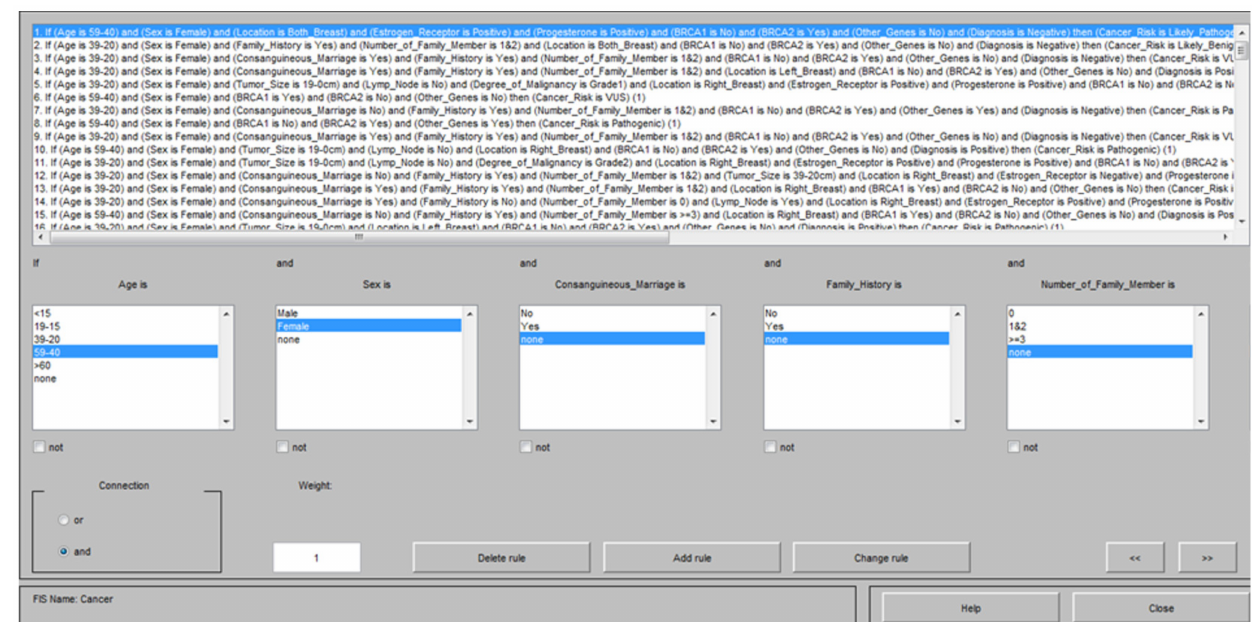
Figure 2. The figure illustrates generated rules section within the Fuzzy Logic system. The upper rectangle box presents an example of the data from 268 patients used that used to train the system. Lower small square boxes show example the parameters (age, sex, consanguineous marriage, family history and number of family members) which were defined as input and membership functions within rule section. Table 3. The table shows the created output cluster for given variant classificiation values. * VUS: